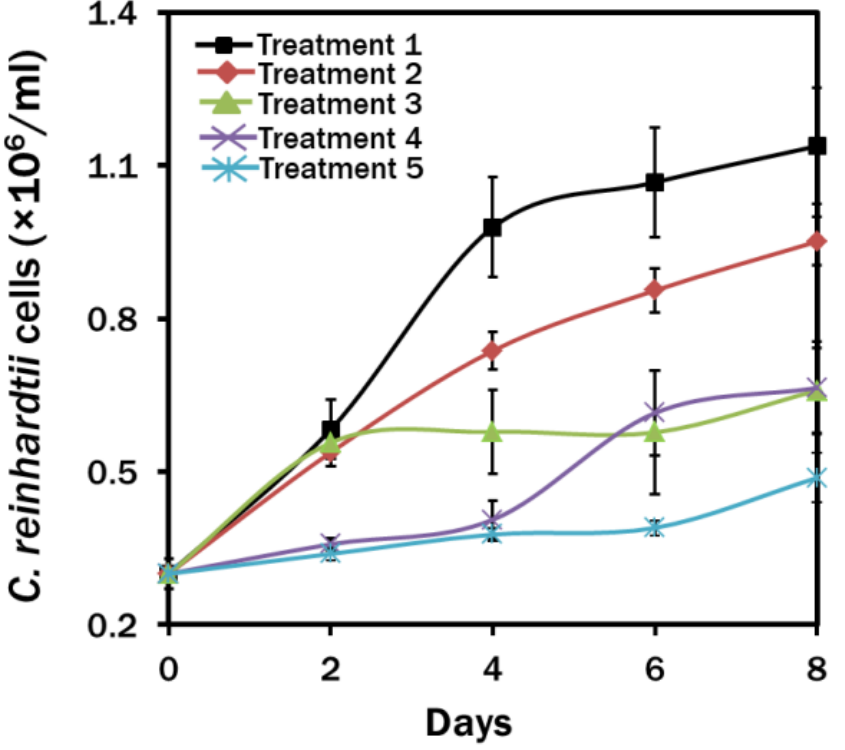
Figure 1. Effects of nutrient and light manipulation on the growth of Chlamydomonas reinhardtii at different time intervals. Treatment 1: MBL medium; Treatment 2: MBL, ( − ) N 2 ; Treatment 3: MBL, ( − ) N 2 , ( − ) Ca 2+ ; Treatment 4: MBL, ( − ) N 2 , ( − ) Ca 2 + , (+) Sodium acetate (2.0 g/L) (24 h light) and Treatment 5: MBL, ( − ) N 2 , ( − ) Ca 2+ , (+) Sodium acetate (2.0 g/L) (24 h dark)